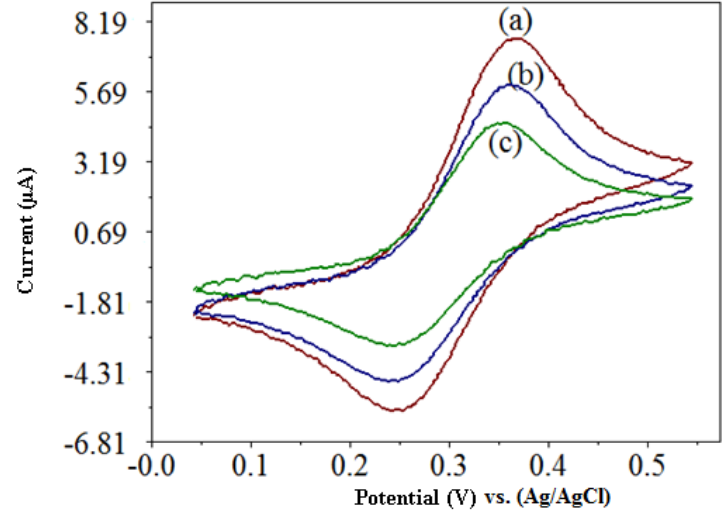
Figure 2. The cyclic voltammograms of the capsaicin biosensor with photocured membrane containing HRP-ferrocene in phosphate buffer pH 7/0.1 M NaCl ( a ); after addition of 123.5 µM H O ( b ); followed by addition of 129.5 µM capsaicin ( c 2 2